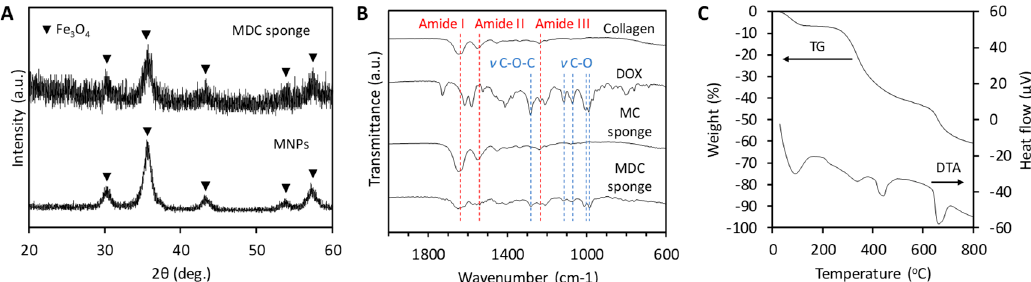
Figure 1. Characteristics of the MNPs and DOX-loaded collagen (MDC) sponges. ( A ) Photograph of the MDC sponge and illustration showing its structure. ( B ) Photograph showing that the MDC sponge is tearable. ( C ) SEM images of the MDC sponge. ( D ) Chemical structure of DOX. ( E ) TEM images of MNPs-8.